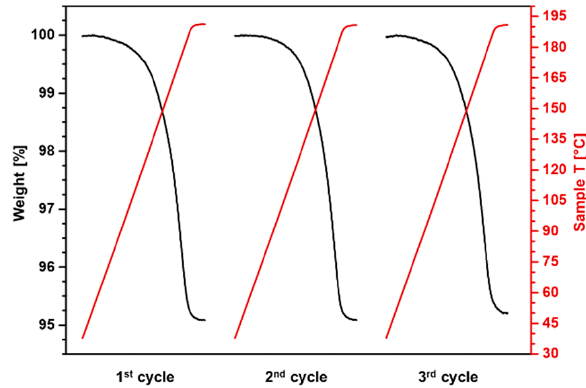
Figure 2. Thermogravimetric analysis showing reversible and ostensibly stoichiometric binding of NO to Co(L) to give Co(NO)(L) over three cycles. The red lines are the heating profile, while the black lines are the weight loss profile.